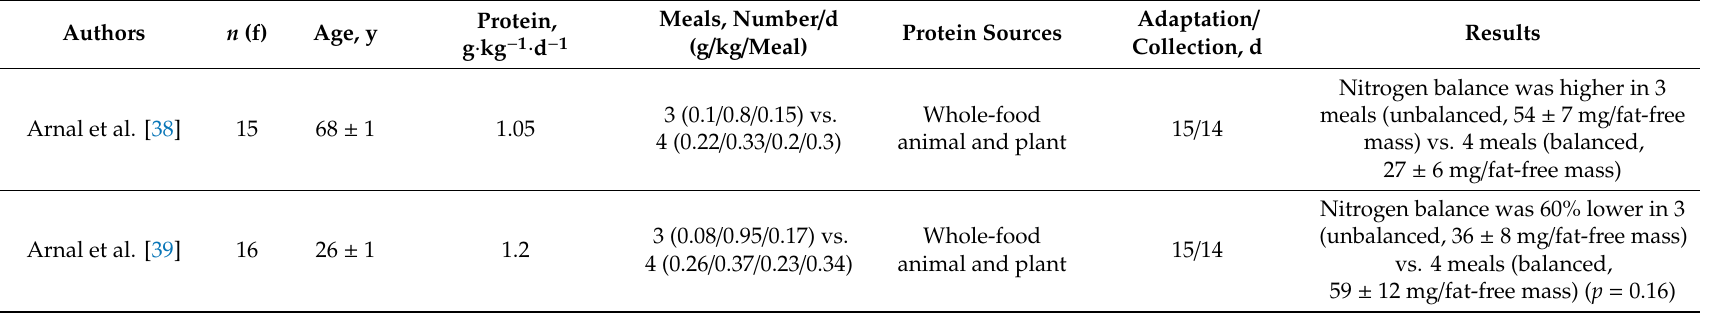
Table 3. Chronic protein ingestion research assessing the e ff ect of protein distribution on nitrogen